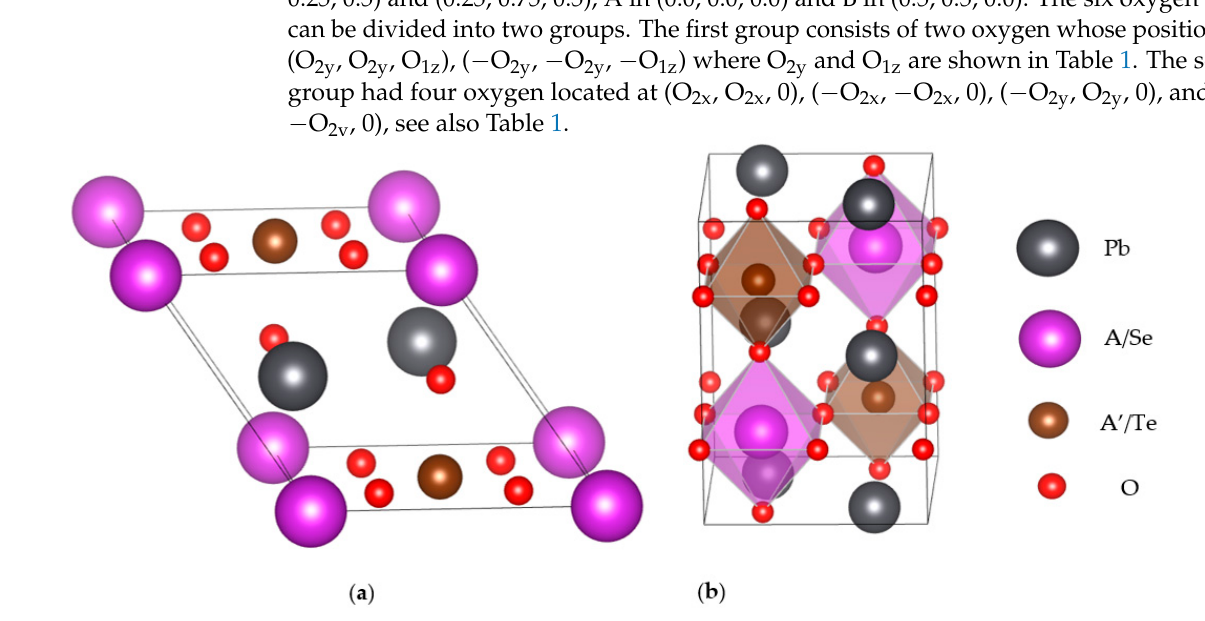
Figure 1. ( a ) Primitive and ( b ) conventional crystal structure of the Pb 2 AA’O 6 (A = Sb and Bi; A’ = Br and I) and Pb 2 SeTeO 6 double perovskites. Table 1. Structural parameters of the fully optimized Pb 2 AA’O 6 structures where Pb (x, y, z) = (0.75, 0.25, 0.5), or (0.25, 0.75, 0.5), A (x, y, z) = (0, 0, 0), A’ (x, y, z) = (0.5, 0.5, 0), O1 (x, y, z) = (O 2y , O 2y , O 1z ), ( − O 2y , − O 2y , − O 1z ) and O2 (x, y, z) = (O 2x , O 2x , 0), ( − O 2x , − O 2x , 0), ( − O 2y , O 2y , 0), and (O 2y , − O 2y , 0). The calculated lattice constant a (in ˚A), c/a ratio, the volume of the primitive cell V 0 ( ˚A 3 /f.u. ) and bandgap (in eV). The bandgap in the brackets is the SOC results.